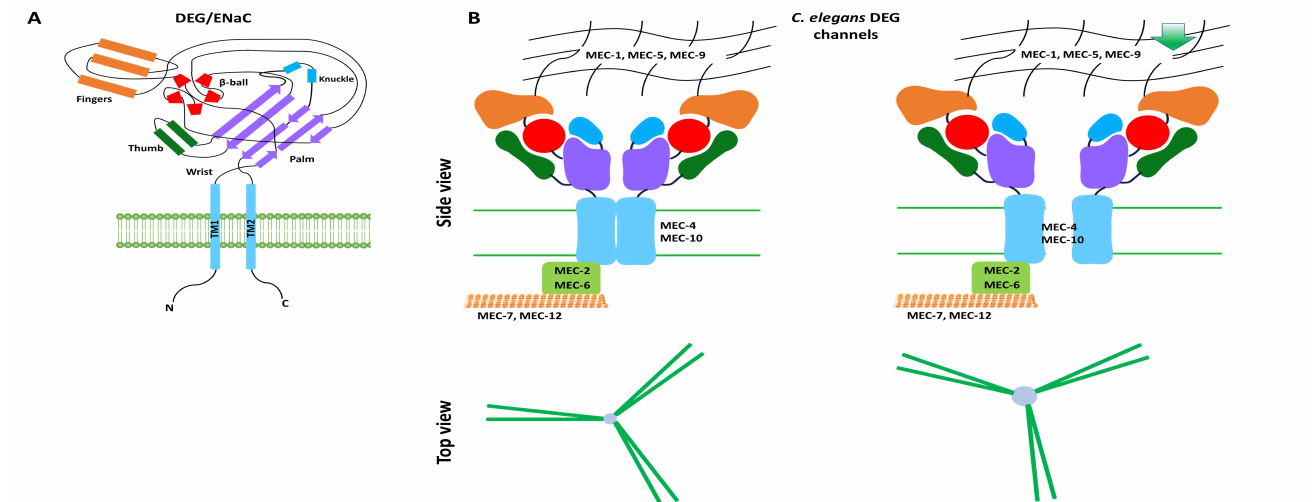
Figure 2. Degenerin (DEG)/Epithelial Sodium Channel (ENaC)/Acid-Sensitive Channel (ASIC) structure and gating. ( A ) Representative cartoon of DEG/ENaC/ASIC channel monomers. DEG/ENaC/ASIC channel monomers share a similar structure composed of two transmembrane domains, N and C terminals, and a large extracellular loop resembling a hand. The wrist connects the transmembrane domain to the seven stranded β -sheet palm and the α -helical thumb, while the β -ball is surrounded by the fingers and knuckle [14–16] (adapted from [15,55]). ( B ) Hypothetical gating mechanism of C. elegans DEG channels. The molecular bases of mammalian ASIC channels mechanical gating are still poorly explored. In the case of C. elegans , it has been established that the pore-forming subunits MEC-4 and MEC-10 interact with the paraoxonase-like and the stomatin-like proteins MEC-2 and MEC-6 [46–48] and with the special tubulins MEC-7 and MEC-12 [44]. In addition, the extracellular matrix components, MEC-1, MEC-5, and MEC-9, might be critical for force transduction [42,43] by directly associating with the pore-forming subunits (adapted from